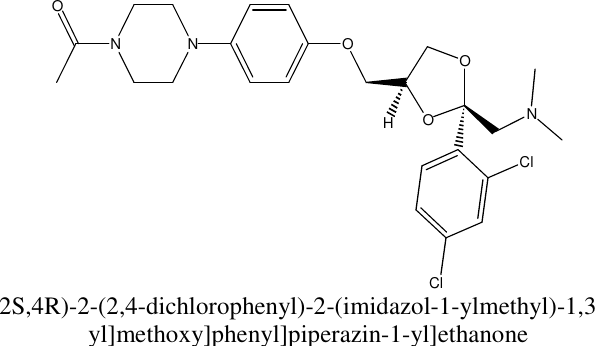
Figure 1. The chemical structure of